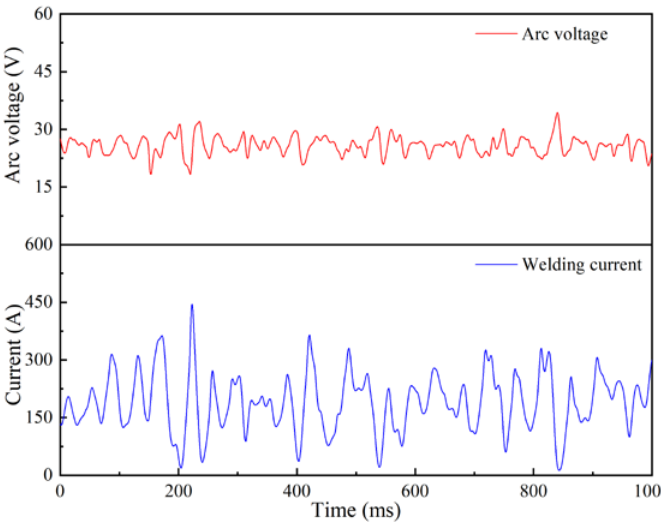
Figure 3. Welding current and arc voltage waveforms of the conventional UWW process.